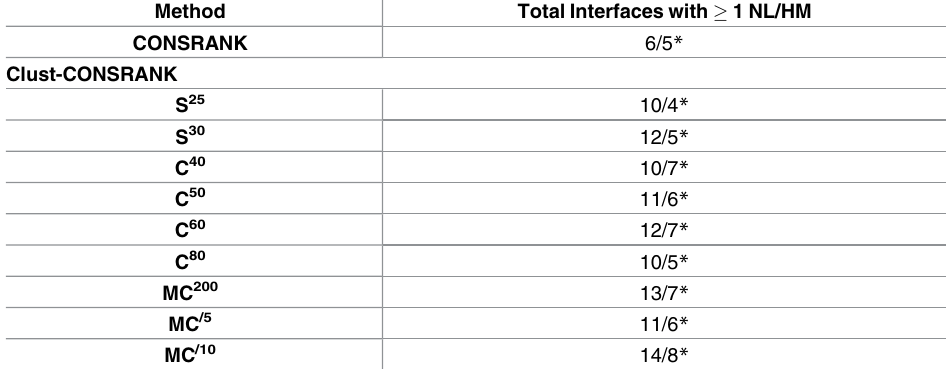
Table 2. Number of interfaces for which at least one acceptable/high-medium quality ( * ) solution has been selected by each scoring